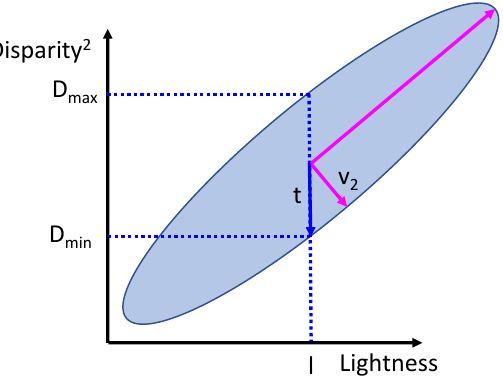
Figure 7. Illustration of disparity tolerance t given a lightness value l